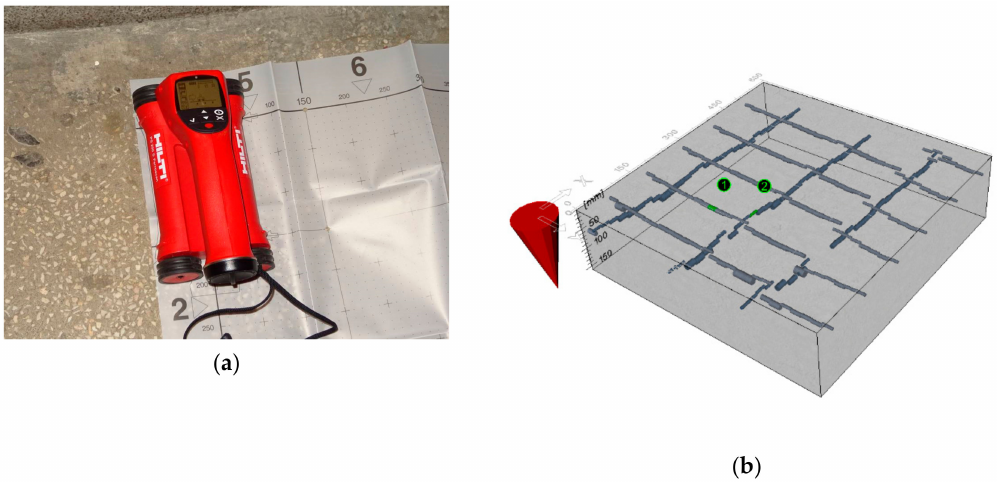
Figure 6. Staircase measurement: ( a ) during measurement; ( b ) view of digital model made in HILTI PROFIS